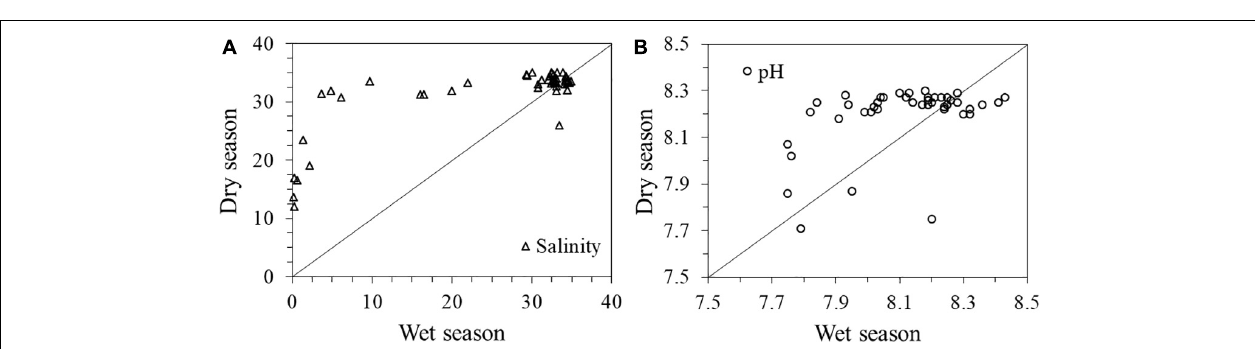
FIGURE 7 | Plots of seawater (A) salinity, and (B) pH in the wet season vs. in the dry